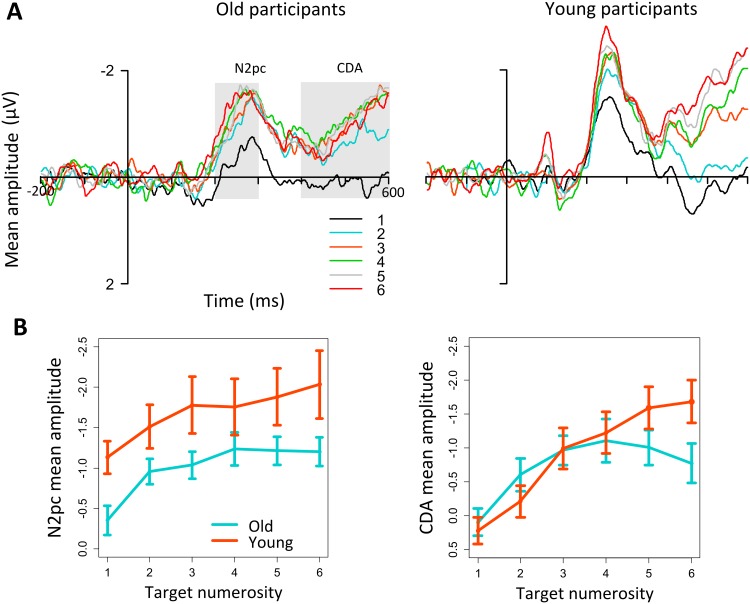
Event related potential results.(A) ERP difference waveforms as a function of age group and numerosity. Panels represent respectively numerosities 1 to 6 for the old group group (left) and for the young group (right). (B) Mean amplitude values for the N2pc (200–300 ms) and CDA (400–600 ms) as a function of age group and numerosity.